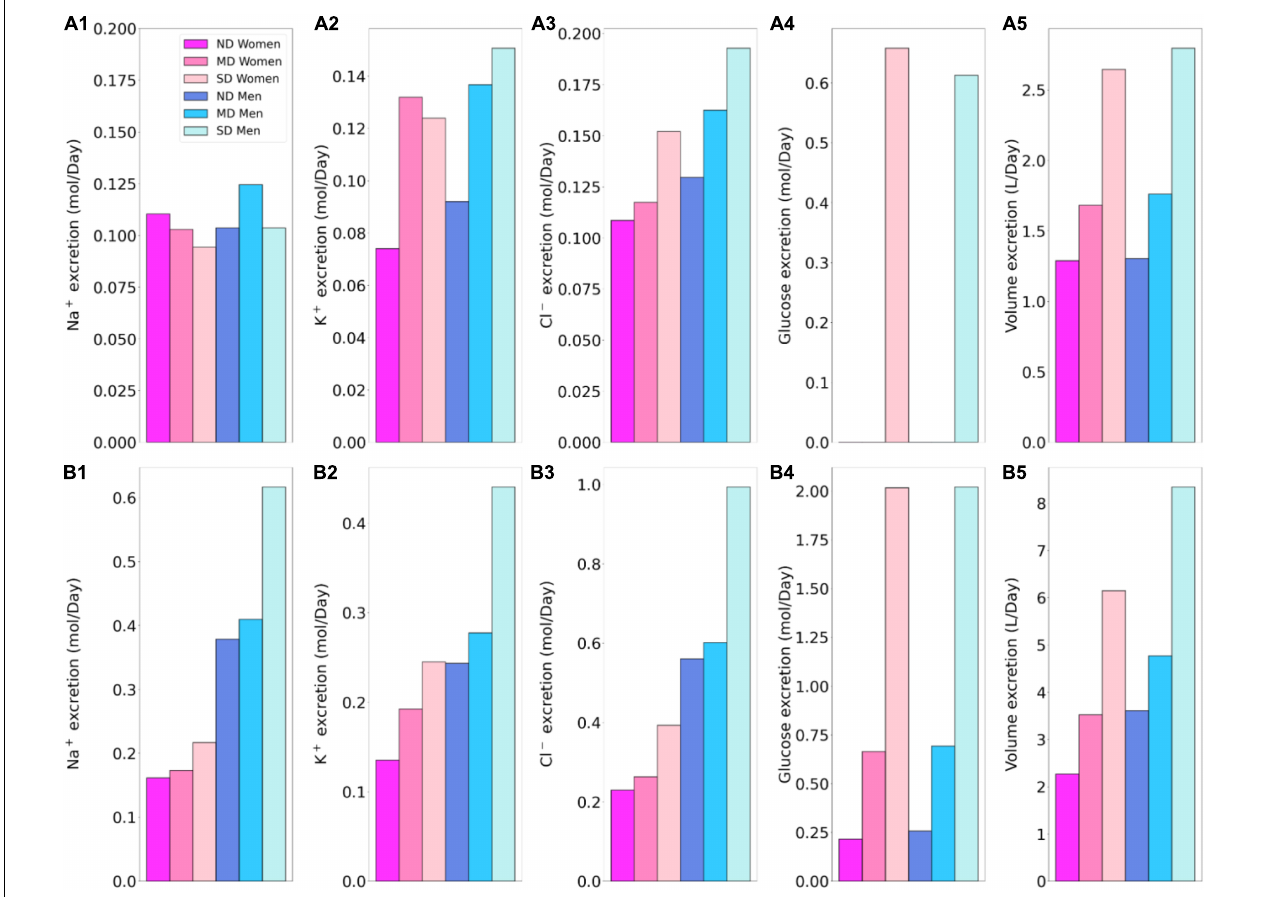
FIGURE 4 | Total excretion of Na + ( 1 ), K + ( 2 ), Cl – ( 3 ), glucose ( 4 ) and fluid ( 5 ) in men and women without ND, with MD, and with SD. Results are obtained under no inhibition (A1–A5) and with SGLT2 inhibition (B1–B5) .